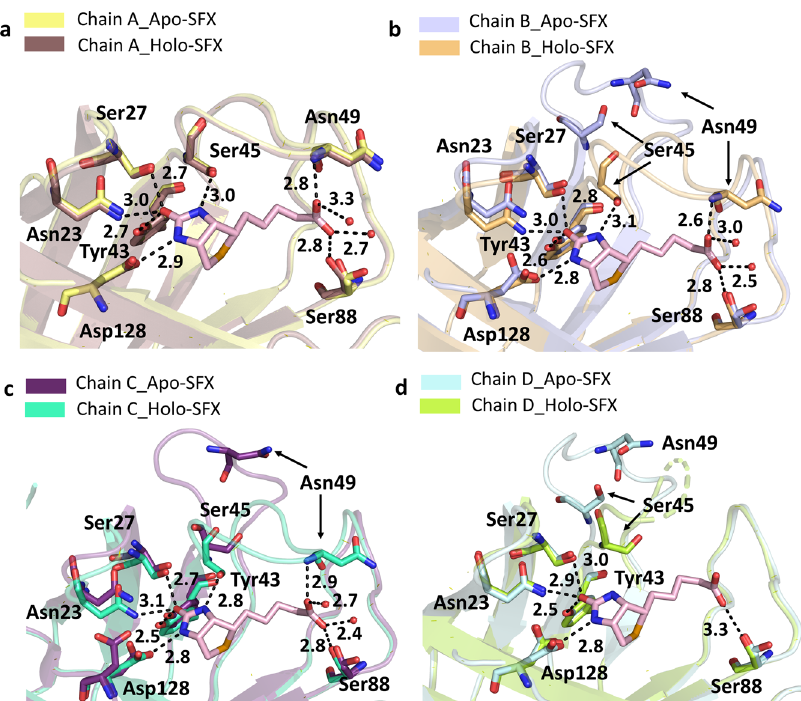
Fig. 3 Superposition of the biotin-binding sites for each chain of the Apo-SFX and Holo-SFX structures. Chains A – D of Apo-SFX is superposed with the Holo-SFX (PDB ID:5JD2) structure of streptavidin in a – d , respectively (Supplementary Table 1). The L3/4 opening as a “ lid ” without selenobiotin binding. Binding of selenobiotin is not symmetric for all four monomers, which represent cooperativity. Selenobiotin and water molecules were represented by light pink sticks and red-colored spheres, respectively. Hydrogen bonds are shown with black dashed lines and their corresponding distance as a unit of Angstrom